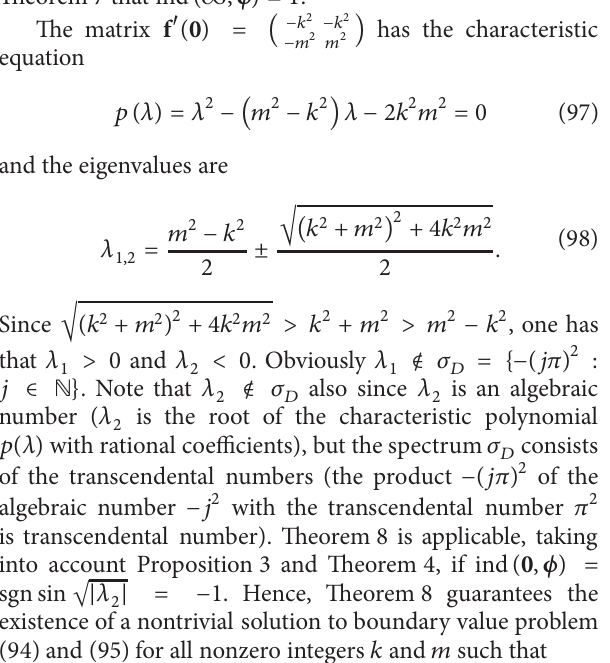
Figure 1: The points (𝑘,𝑚) (1 ≤ 𝑘,𝑚 ≤ 10) with integercoordinates such that 𝑘 and 𝑚 satisfy condition